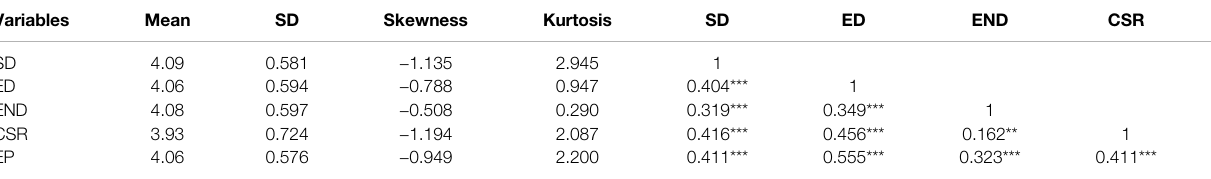
TABLE 2 | Descriptive statistics and correlation analysis of the study variables. Variables